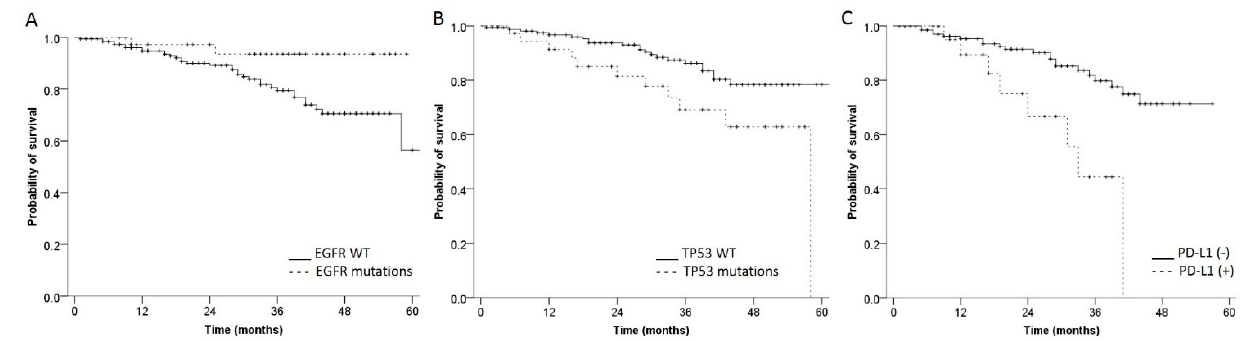
Figure 6. Overall survival plots according to EGFR , TP53 mutational status and PD-L1 expression. Kaplan–Meier curves show differences in overall survival according to EGFR ( A ) or TP53 ( B ) mutational status. A similar analysis was performed in panel ( C ) by separating tumors with high (+) and low-to-negative PD-L1 expression (-) (see Materials and Methods for details).